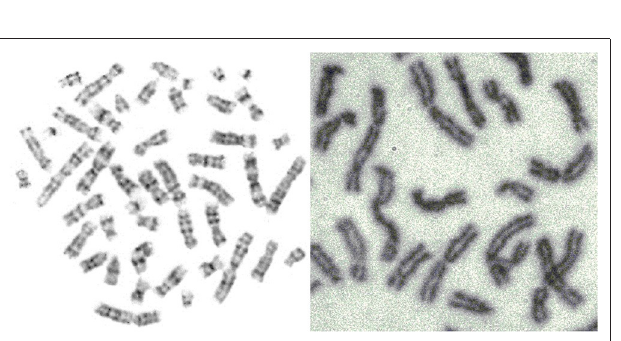
FIGURE 5 | Mitosis-two chromosome distributions (Jovanovi´c, 2001; Jovanovi´c et al.,